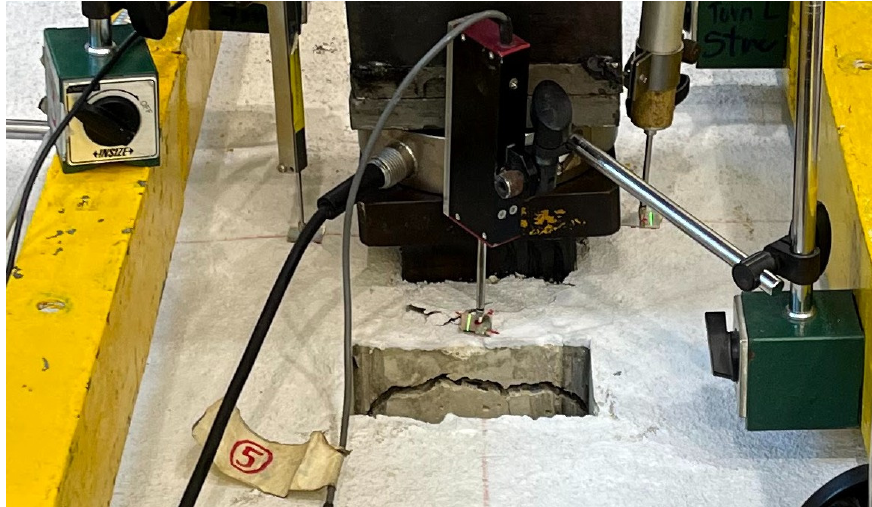
Figure 12. Typical cracks and punching of steel plate on compression side.